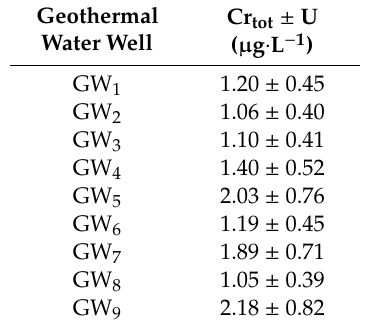
Table 2. Results of Cr determination and measurement uncertainty (U).